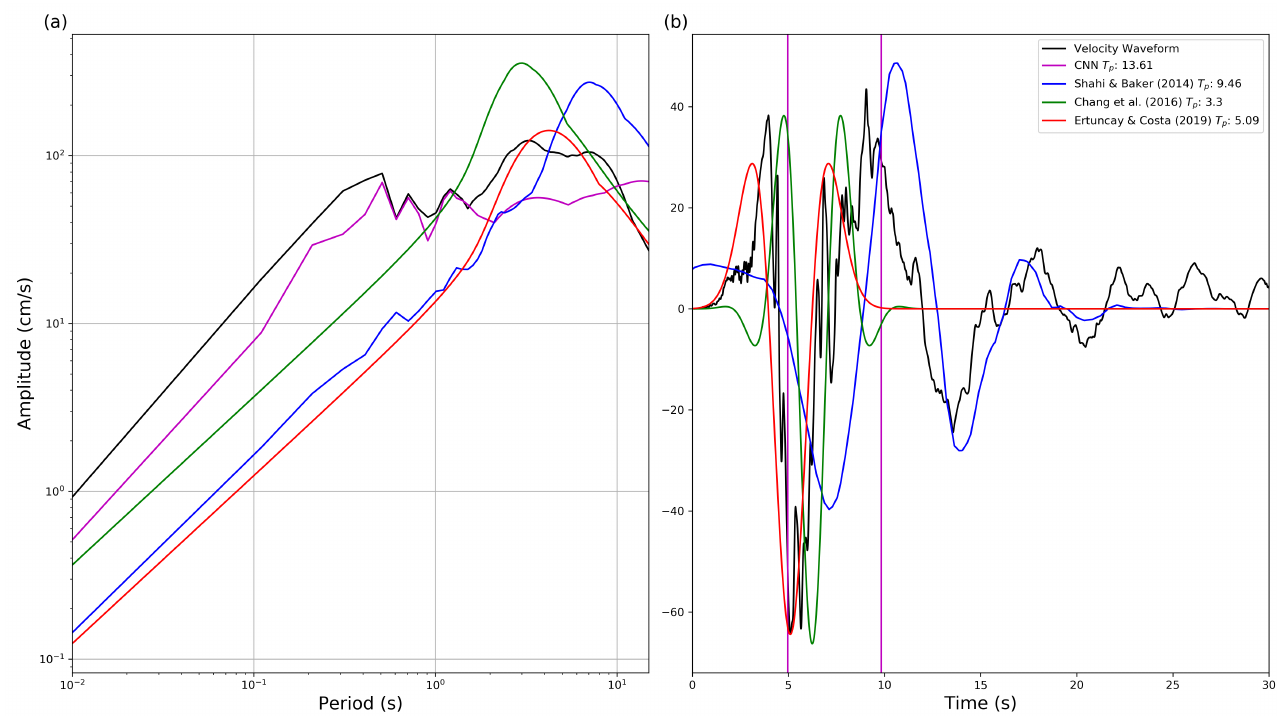
Figure 5. ( a ) Spectral response and ( b ) velocity waveform of the 15th of October 1979 Imperial Valley, USA earthquake ( M w = 6.5) recorded at El Centro Array #5 station ( R jb = 29.5km) along with fitted waveforms and their spectral responses of previous studies. Colour and T p information are the same as in Figure